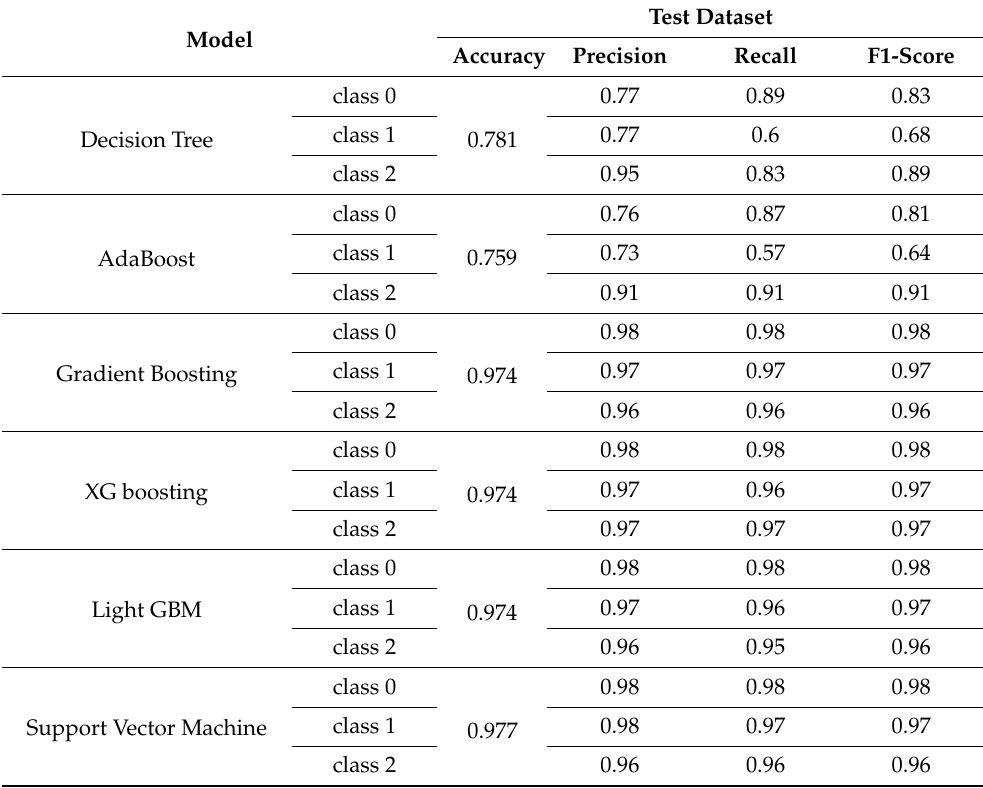
Table 9. Evaluating classification performance (step 1) for EPB TBM